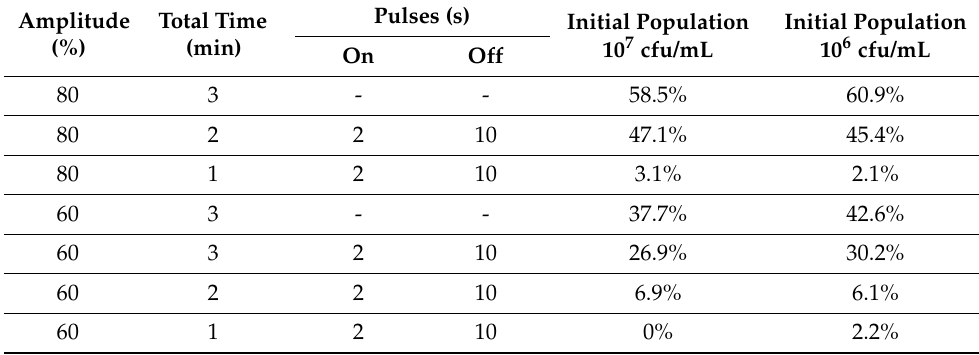
Table 4. Viability loss percentage for different proven conditions in the attenuation setup.